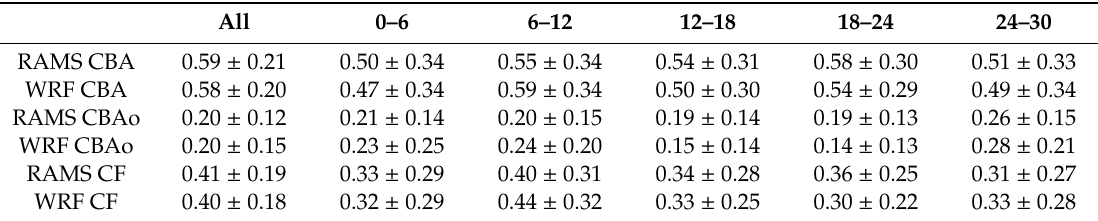
Table 3. Mean and standard deviation of forecast scores for the full forecast (All) and for each 6 h forecast period. Scores for CBA and CF for each model. CBAo are scores calculated only for times when CBA existed for both the model and ceilometer.